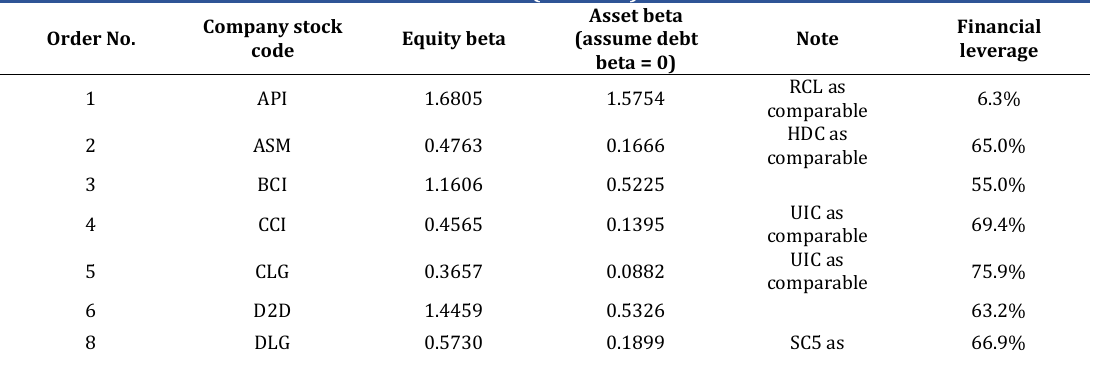
Table 3: Market risk of listed real estate firms (t = 20%) Order